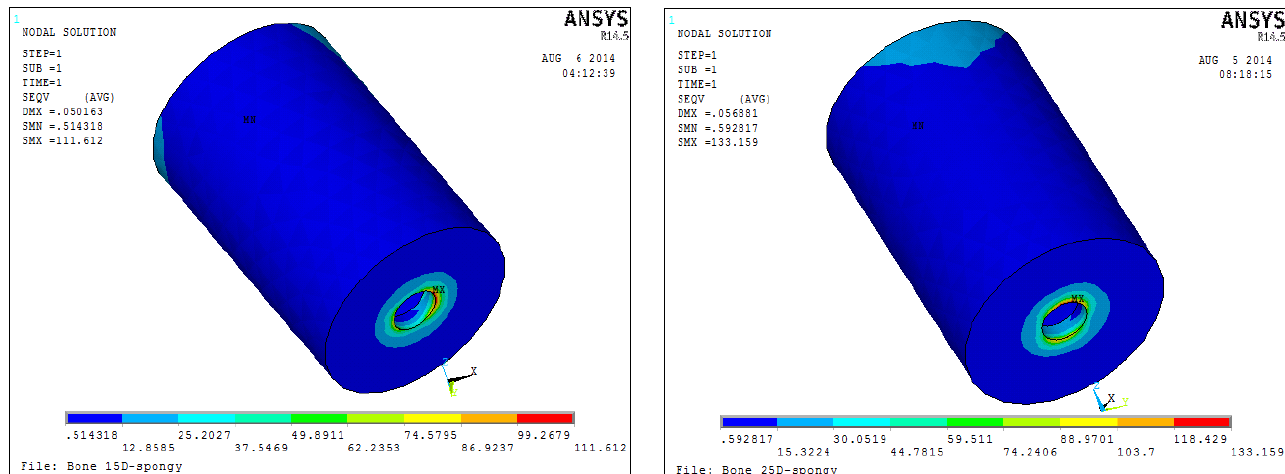
Fig. 3: Cortical bone Von Mises stress distribution comparison between (a) 15°, (b) 25° angulated abutment under Zirconia crown